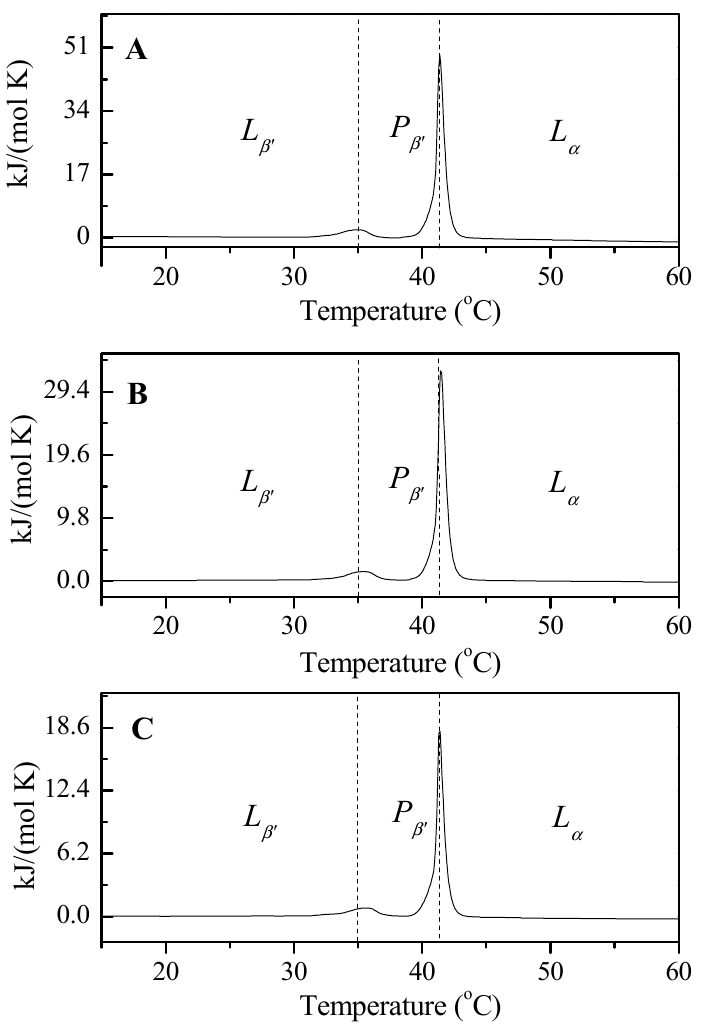
Figure 9. The influence of the pH environment on the temperature of L DPPC/5-MBT liposomes phase transitions. ( A ) pH 4.47; ( B ) pH 5.59; ( C ) pH 6.10. transitions. ( A ) pH 4.47; ( B ) pH 5.59; ( C ) pH